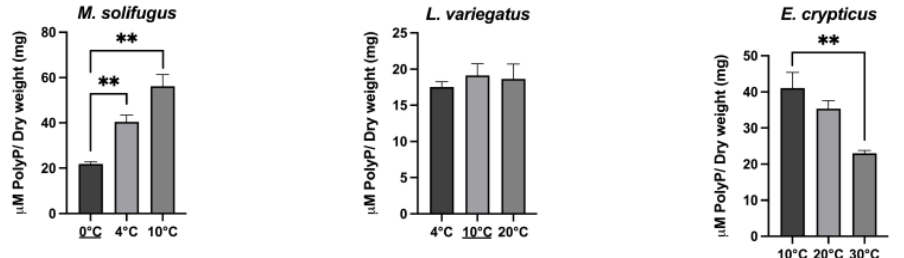
Figure 4. Increased temperature increases the levels of mitochondrial polyP in ice worms, but not in the other mesophilic counterparts. Using the same methods to assay polyP as under control conditions, we observed a significant temperature-dependent increase in the levels of polyP in M. solifugus, which was not present in the other mesophilic counterparts. Underlined temperature is the optimal temperature for each of the annelids. Data are expressed as mean ± SEM of, at least, three independent experiments conducted using biological triplicates. Values of p ≤ 0.05 were considered significant (** p ≤ 0.01).